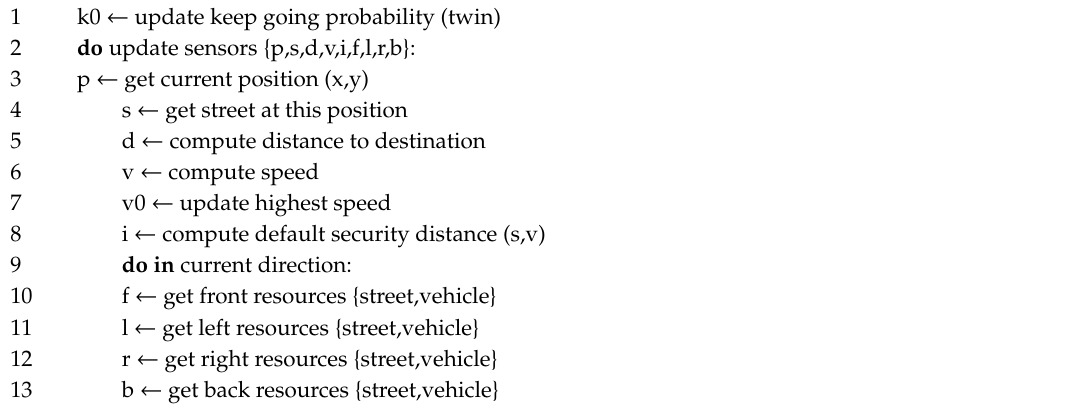
Algorithm 3. Perception activity of the vehicle agent. Sensors k0, v0, and i can depend on twin driver agents, too.